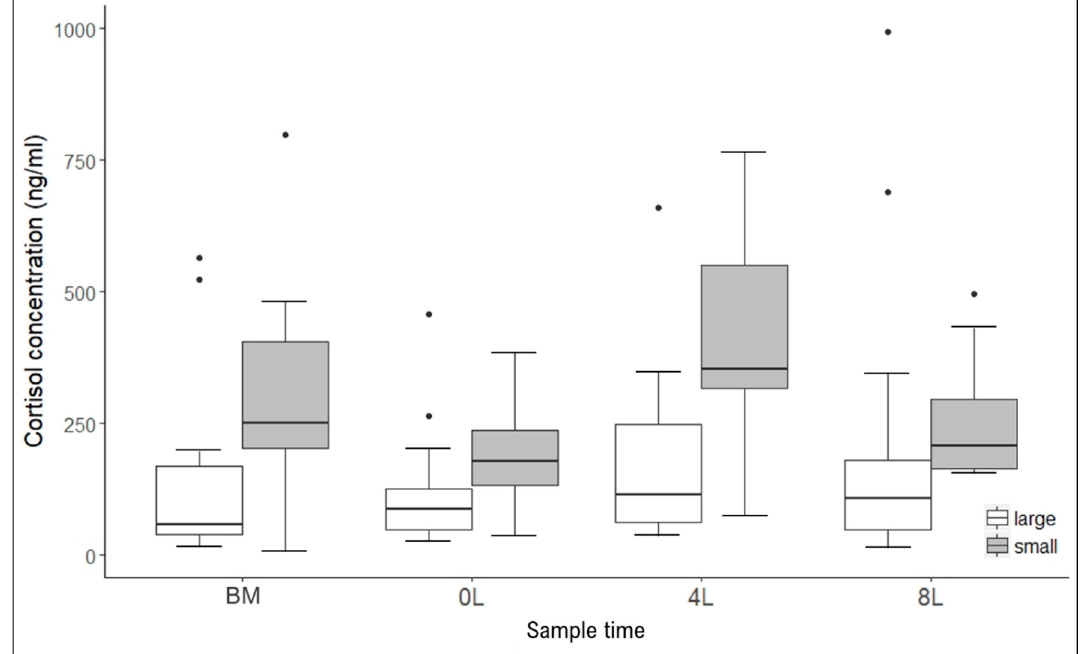
Figure 2. Cortisol concentrations in females of the domestic cat with small (grey boxes) and large (white boxes) litters at different sampling points. BM: before mating, 0L: after parturition (0 weeks of lactation), 4L: 4 weeks of lactation, and 8L: 8 weeks of lactation. Plotted are the median (horizontal line in the box), lower and upper quartiles (horizontal box boundaries), and minimum and maximum values, within the interval upper quartile + 1.5 inter-quartile range and lower quartile − 1.5 inter-quartile range (whiskers); black dots indicate outliers.